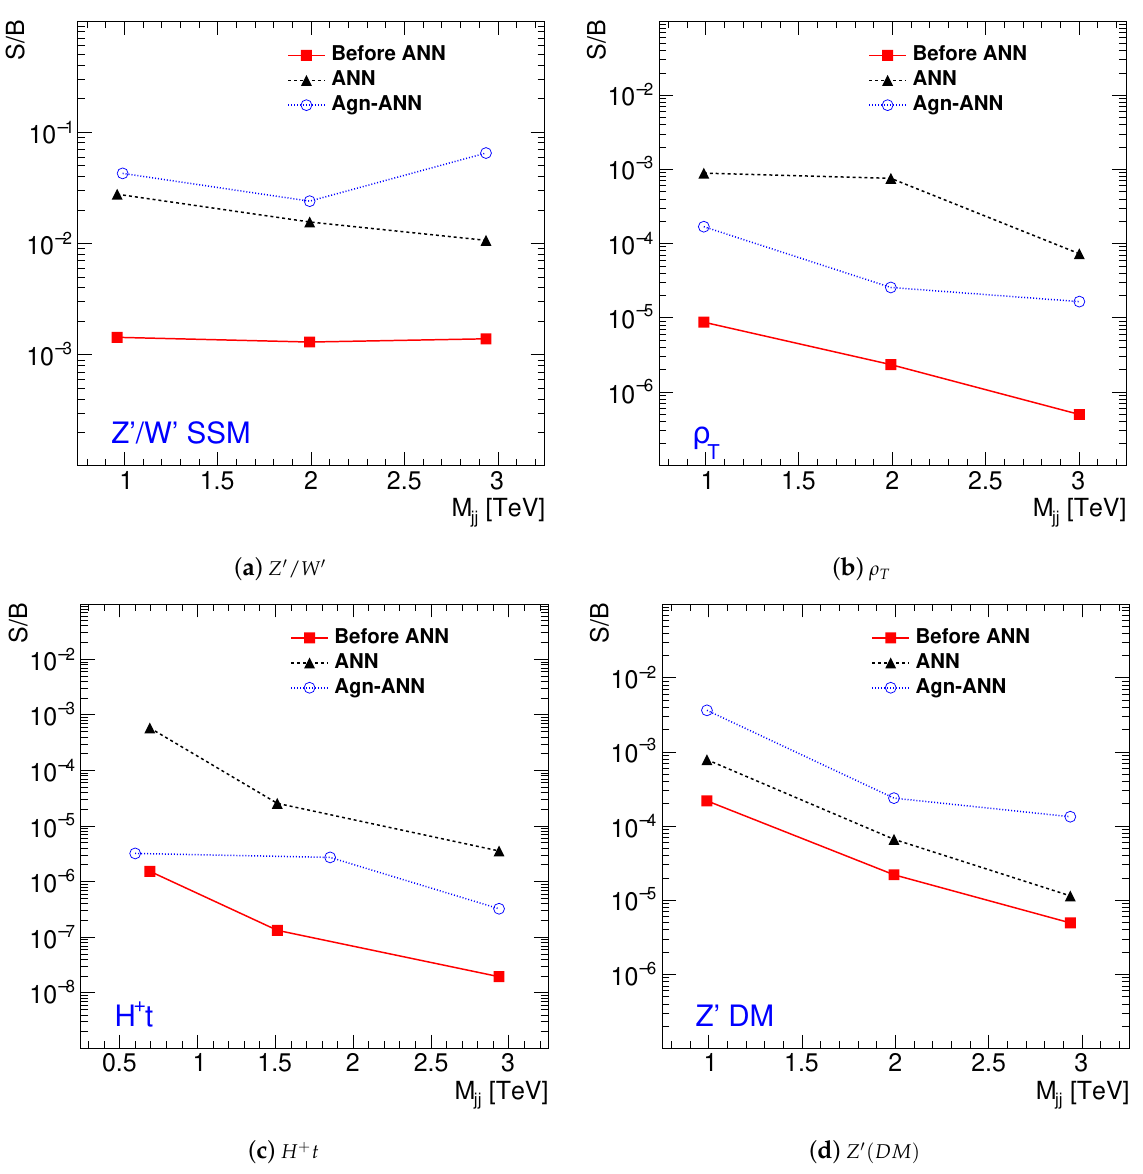
Figure 6. The values of the signal-over-background (S/B) ratios for three masses of BSM heavy particles that create M jj peaks. The values are shown for the original M jj distribution, after applying cuts on the output nodes of the corresponding BSM event types (labeled as “ANN”), and for a model-independent (agnostic) selection (labeled as “Agn-ANN”) without using the BSM events for the ANN training. The latter S/B ratios were obtained by filtering out the SM processes after requiring that the SM output nodes should have values smaller than